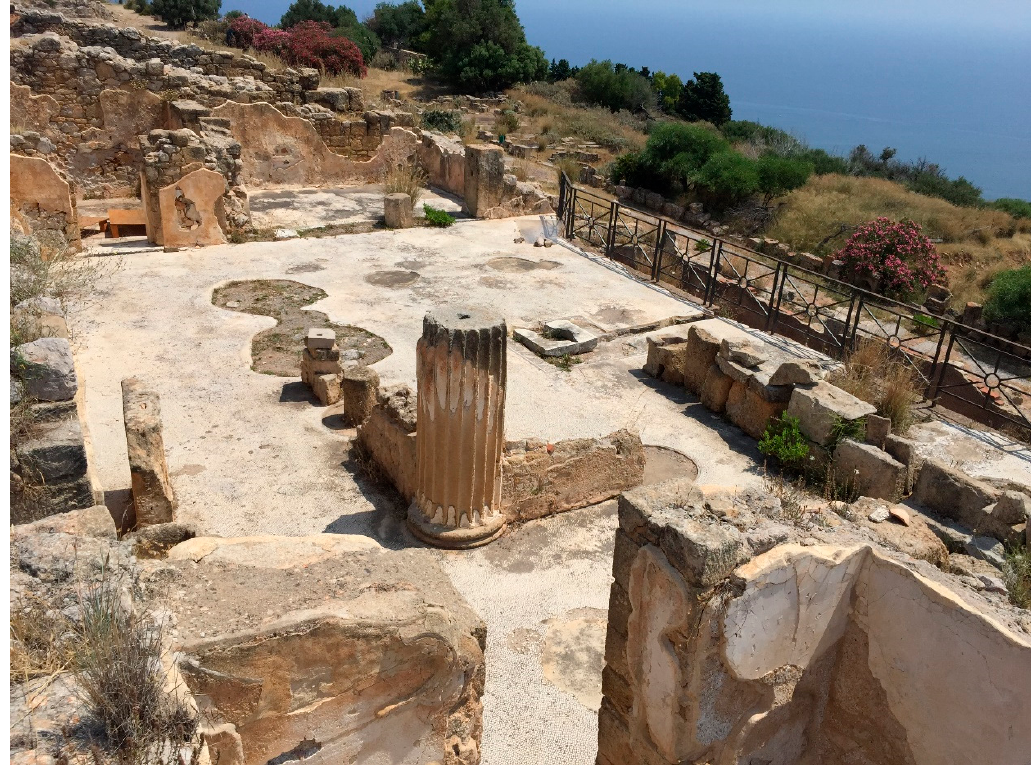
Figure 2. Soluntum, House of Leda, peristyle (photo by the author).